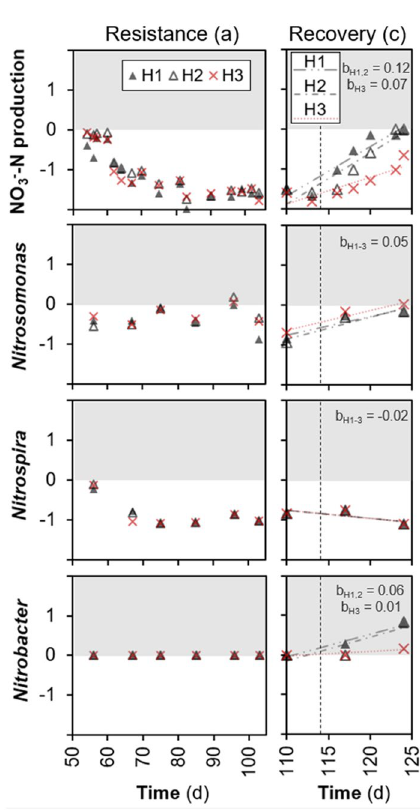
Figure 6. Stability metrics of resistance ( a ), resilience ( b ) and recovery ( c ) for the nitrite oxidation function and nitrifier abundances across disturbed replicate reactors, adopted from 4 . Vertical dashed line indicates removal of disturbance. Dotted and dash-dotted lines represent linear regression fitting per replicate, with the slope ( b ) being the measure of resilience. Benchmarks: a = 0, maximum resistance; a < 0, low resistance through underperformance; b > 0, recovery; b < 0, further deviation from undisturbed control; c = 0, maximum recovery; c < 0, incomplete recovery; c > 0,